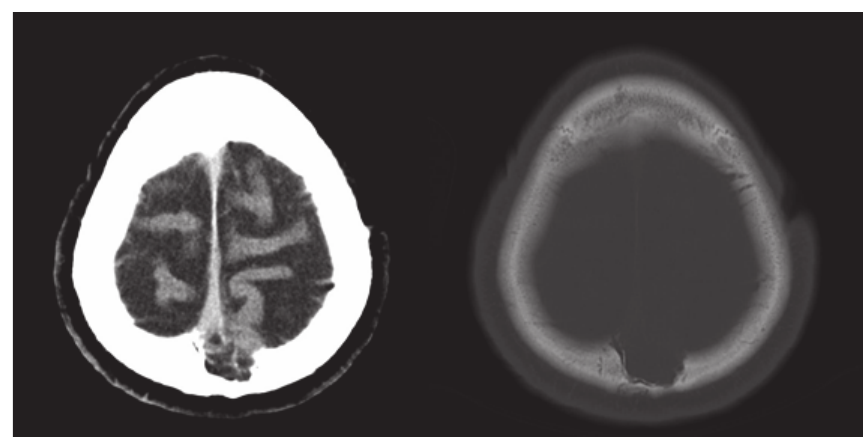
Figure 1: Head CT scan images show an incomplete bone defect in the left parietal bone, with heterogeneous density, including calcified areas.